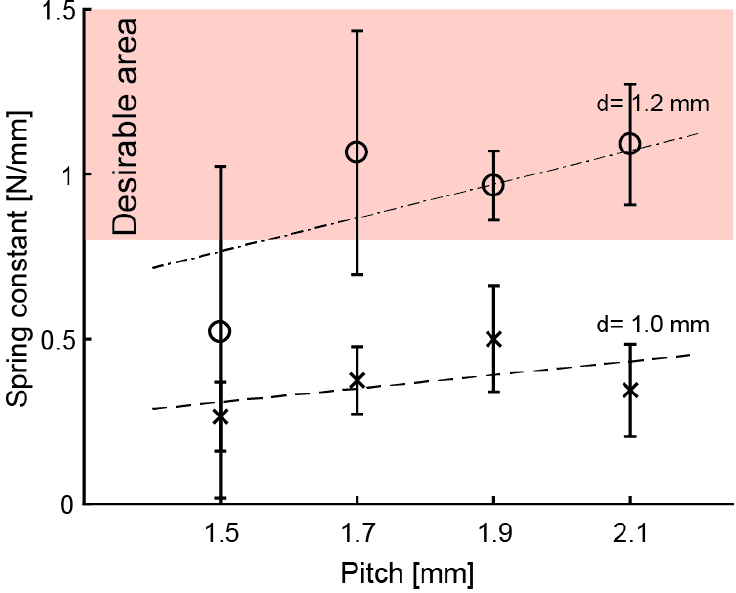
Figure 6. Means of spring constants. Error bar means standard deviation.